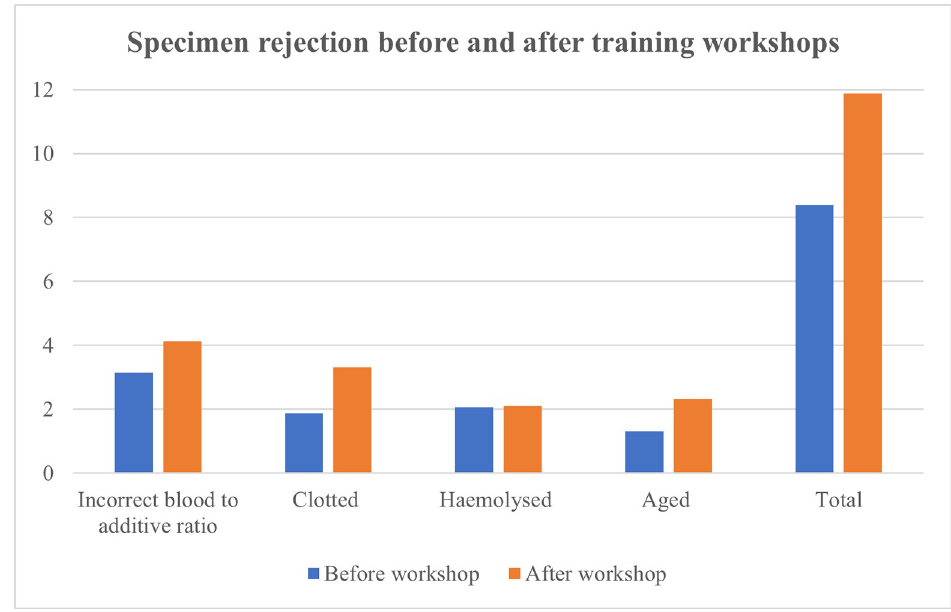
Fig 5. Comparison of coagulation specimen rejection percentages for each of the four principal pre-analytical variables before and after the presentation of training workshops.